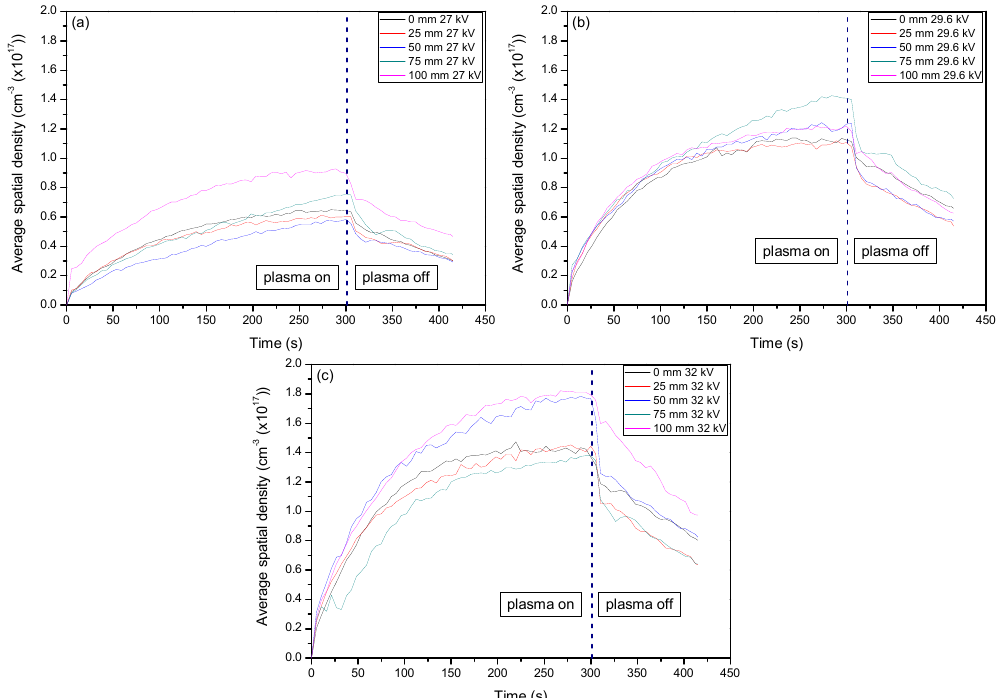
Figure 2. Average spatial density profile of O 3 when CO 2 was introduced to the plasma discharge. The line divides values at the point when the plasma system was set to stop generating plasma. ( a – c ) show the changes of O 3 average spatial density with respect to the change of voltage settings. The EEDF results from the use of ambient air in the central regions (25–75 mm) show that, over time, the electron energies began to dissipate while the edges of the system (0 mm and 100 mm) maintained their values. This can be described as the same reasoning for the formation of O 3 over time. Due to the increased residence time within the system, the excited nitrogen species became